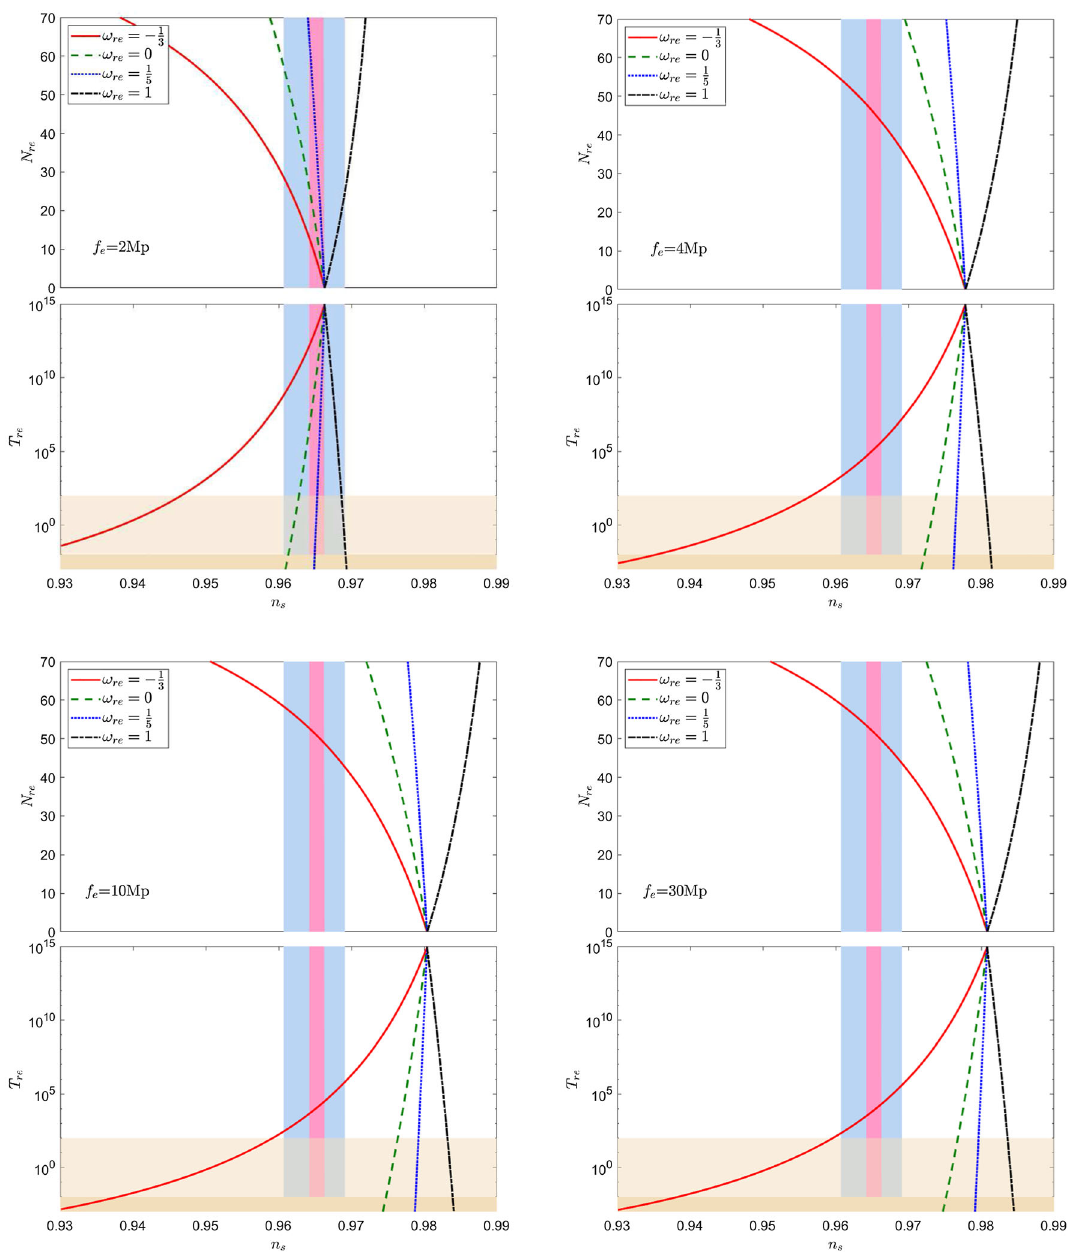
Fig. 5 The duration of reheating N re and the temperature T re as a function of n s are plotted for different parameters f e and ω re of the ENI model. The legend of the shadow area refer to Fig. 3